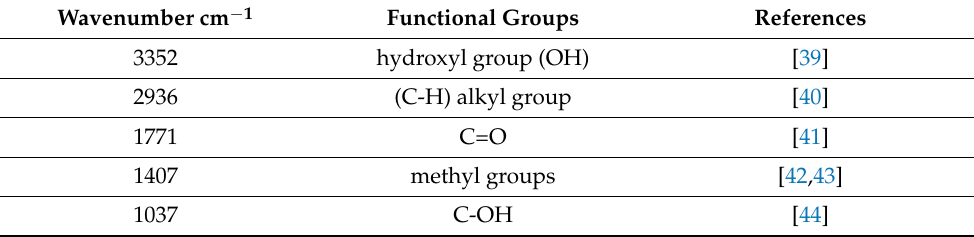
Table 1. FT-IR spectroscopy analysis of the phlorotannins extracted from S. linifolium